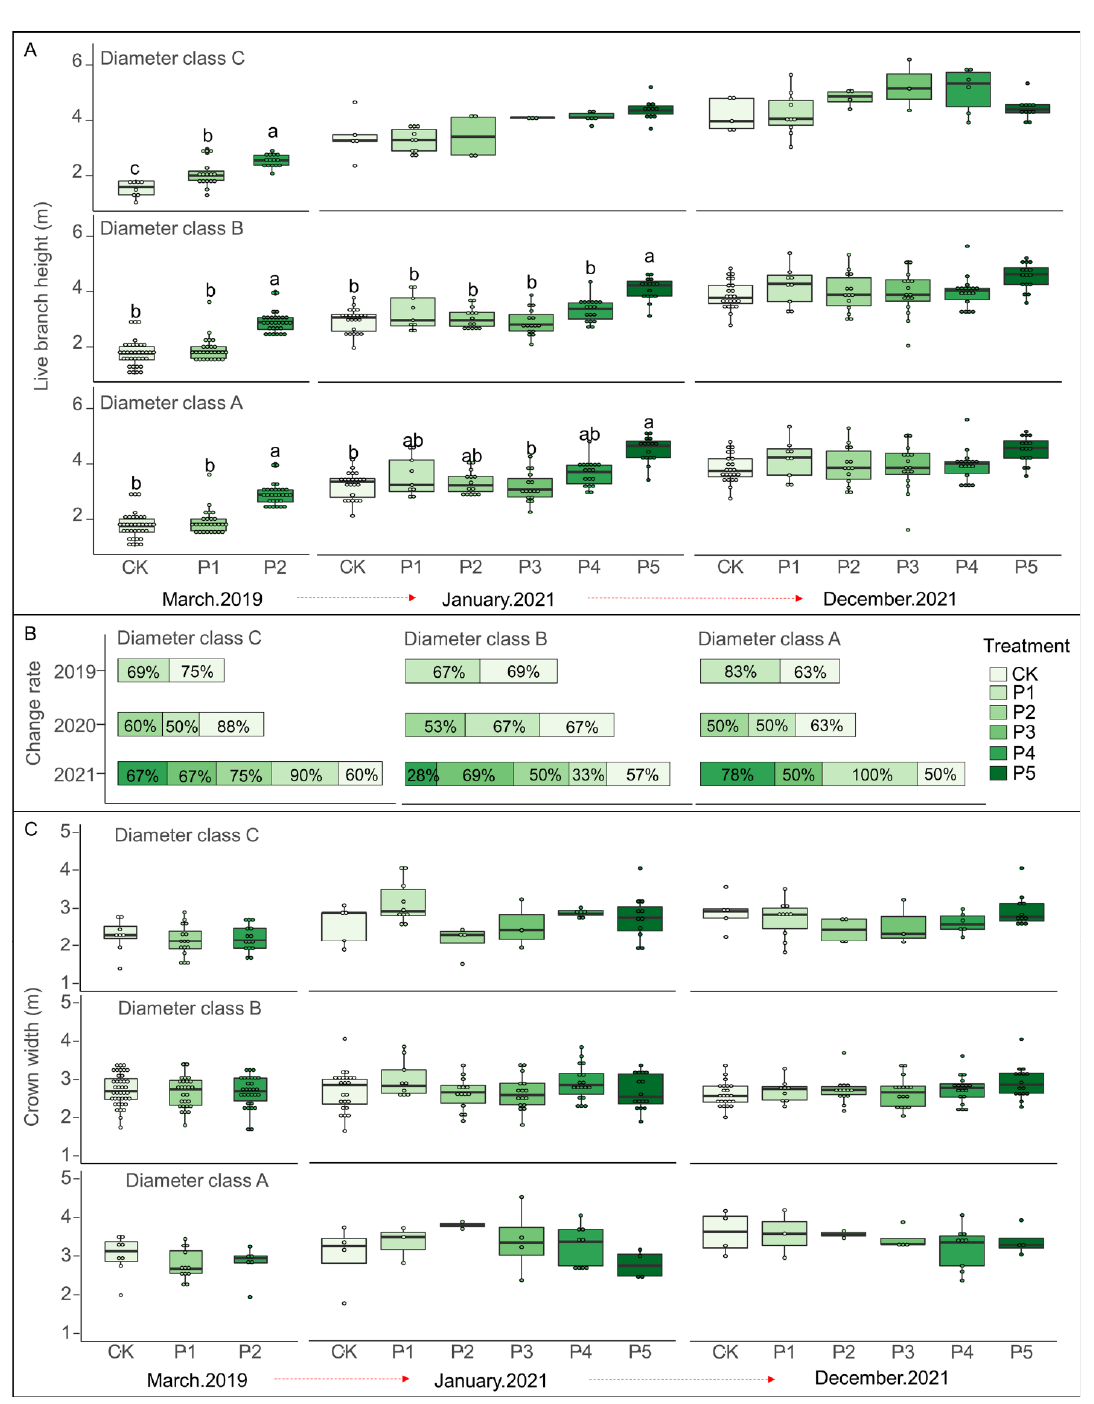
Figure 5. Effects of pruning on live branch height and crown width in P. massoniana plantation. Panels ( A – C ) represent the live branch height ( LBH ) at different times, and annual change rate in LBH and crown width ( CW ) at different times, respectively. In panels ( A , C ) the gradations of green from light to dark represent treatments CK, P1, P2, P3, P4 and P5, and the circles represent the data distribution in each treatment. Lowercase letters in the figure indicate the significant difference between treatments ( p <